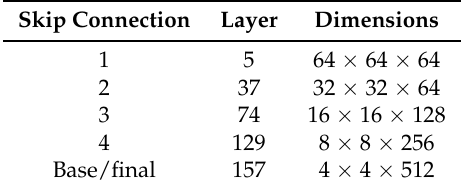
Table 4. ResNet34-U-Net Skip Connections.